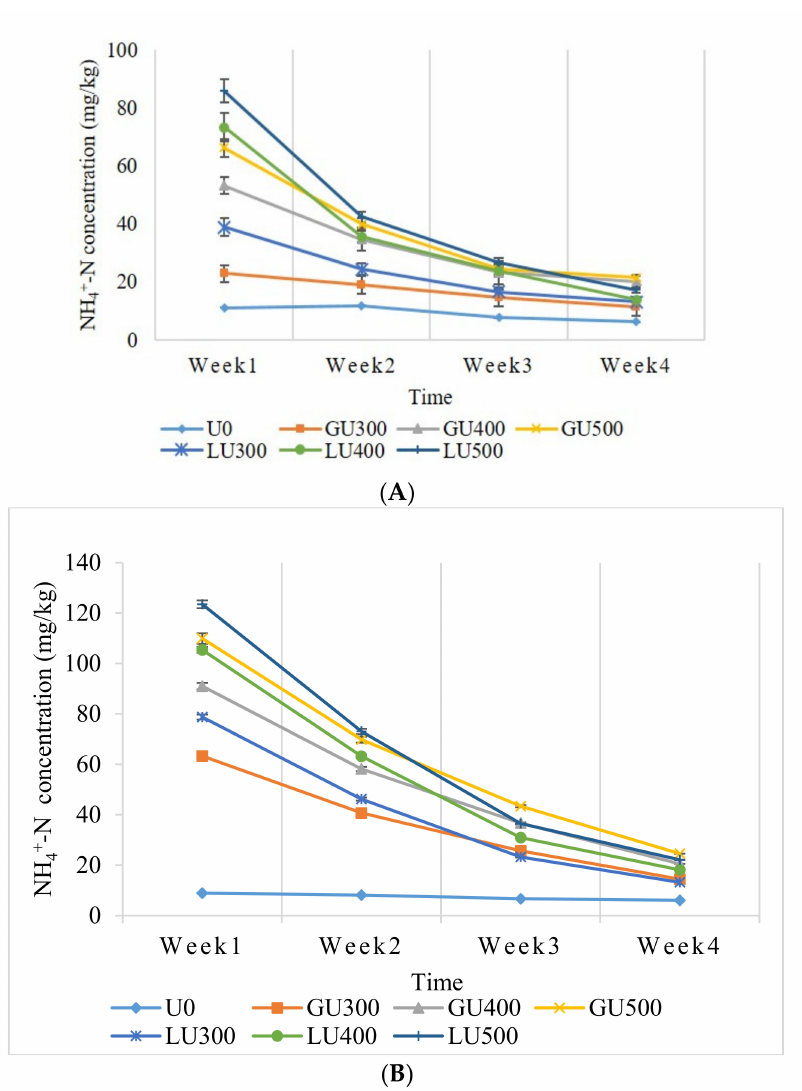
Figure 1. NH 4+ -N concentration (mg/kg) in Bungor ( A ) and Selangor ( B ) soils treated with different rate of LU and GU fertilizers during the four weeks of incubation. Vertical bars on the graphs show the standard